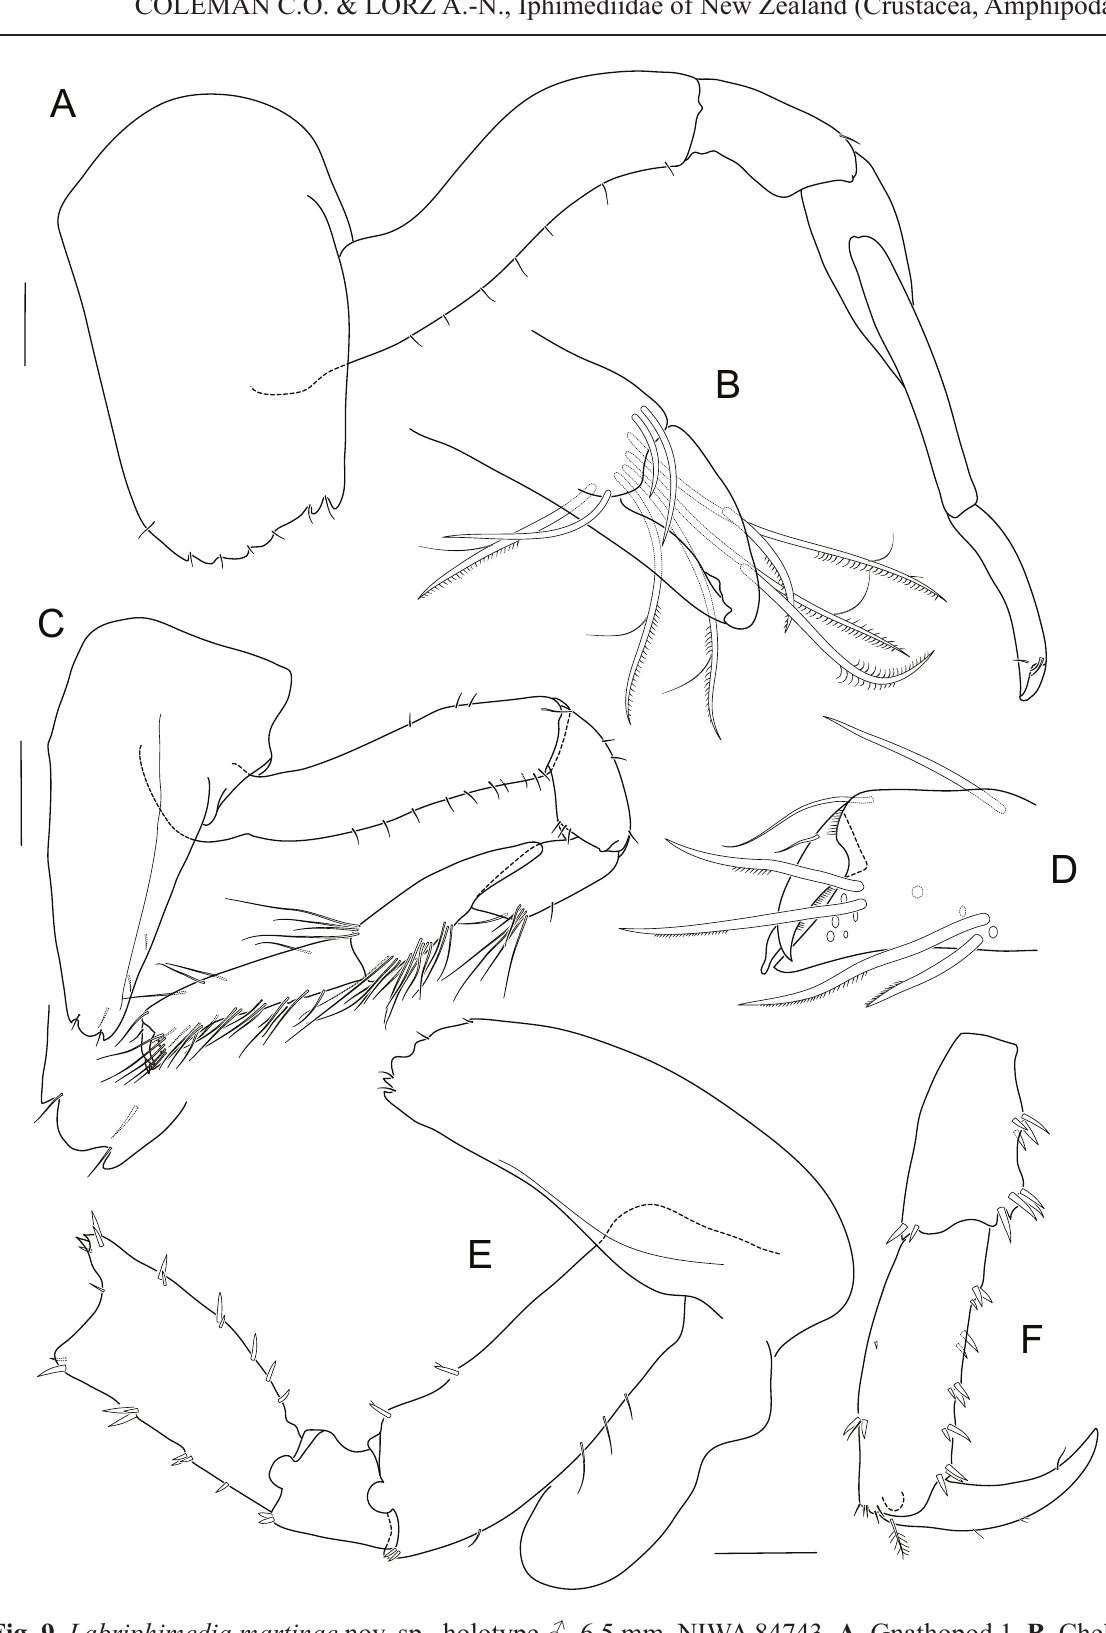
Fig. 9. Labriphimedia martinae nov. sp., holotype ♂, 6.5 mm, NIWA 84743. A . Gnathopod 1. B . Chela of gnathopod 1. C . Gnathopod 2. D . Chela of gnathopod 2. E . Pereopod 3. F . Presumed carpus to dactylus of pereopod 3. Scale bars: a, C, e-F = 100